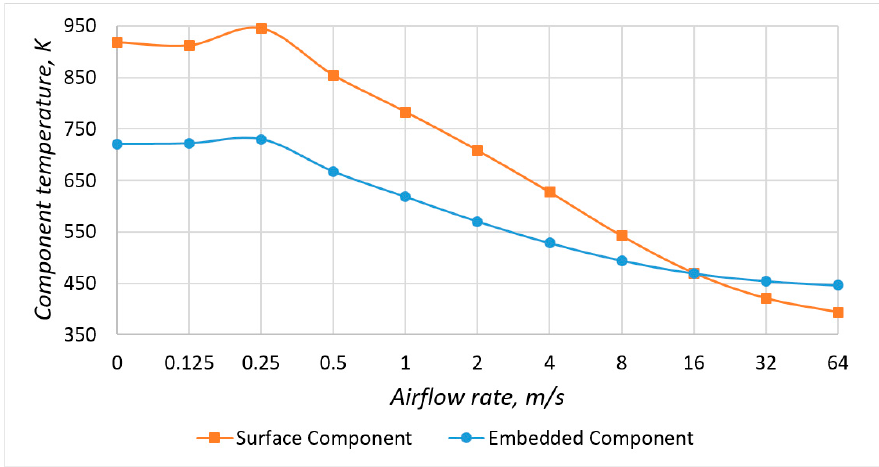
Figure 9. Dependence of the component temperature on the airflow rate in models without a copper